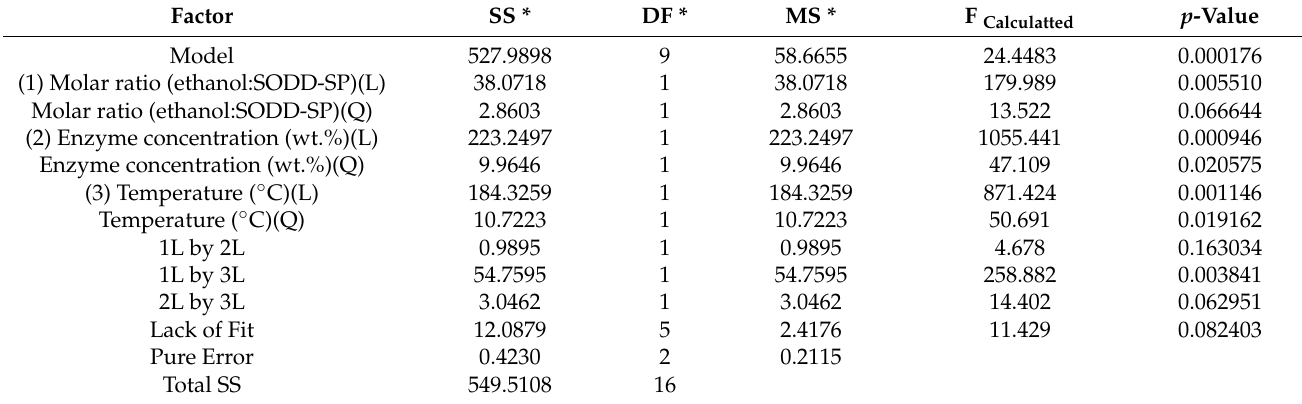
Table A3. Analysis of variance (ANOVA) for ester yield (wt. %) from SODD saponifiable phase (SODD-SP) (response variable) as function of the independent variables (ethanol:SODD-SP molar ratio, enzyme concentration and